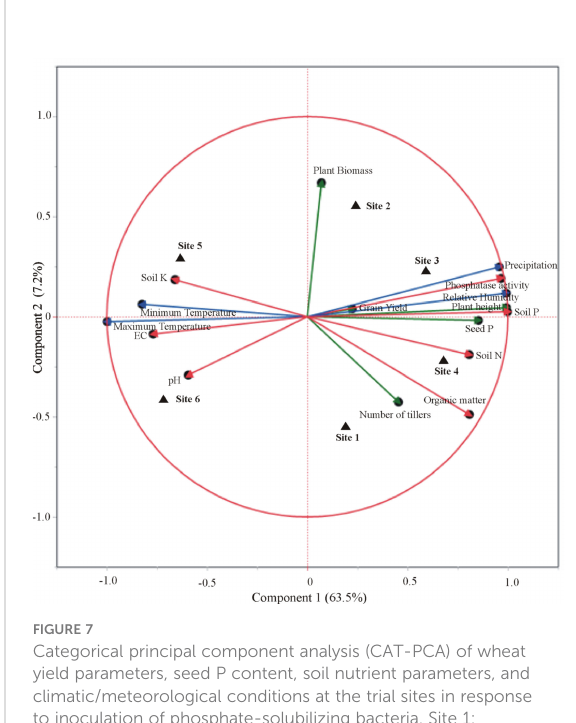
FIGURE 7 Categorical principal component analysis (CAT-PCA) of wheat yield parameters, seed P content, soil nutrient parameters, and climatic/meteorological conditions at the trial sites in response to inoculation of phosphate-solubilizing bacteria. Site 1: Faisalabad, Site 2: Nankana Sahib, Site 3: Pindi Bhattian, Site 4: Hazara, Site 5: Husri, and Site 6: Tando